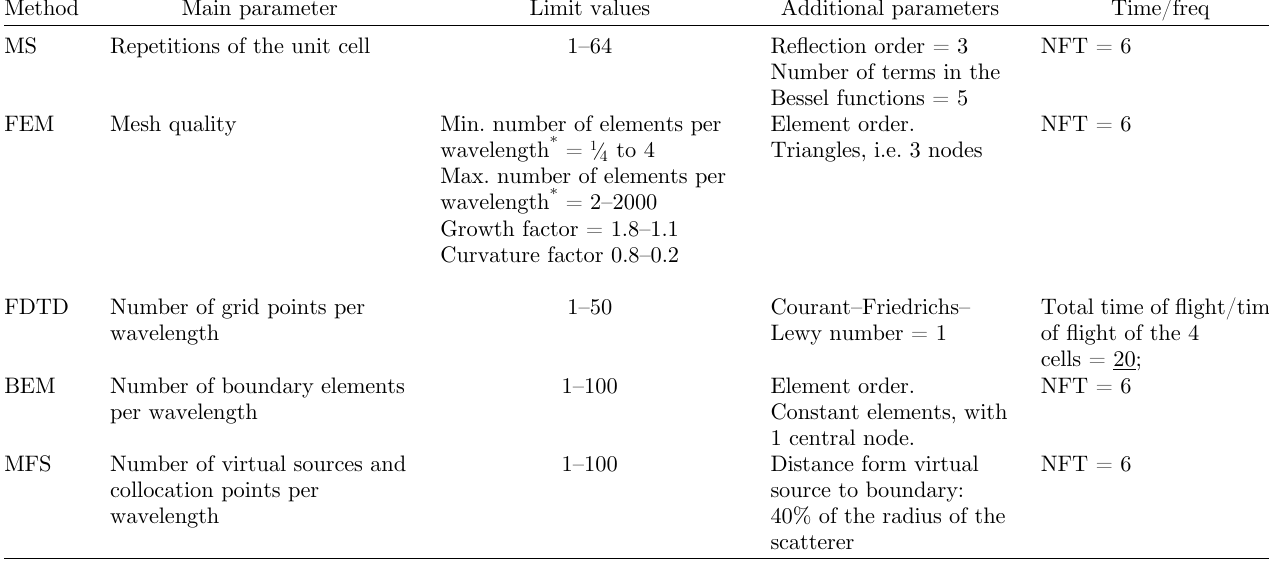
Table 1. Numerical values of the main parameter considered in each of the simulation methods, as well as the secondary parameters.